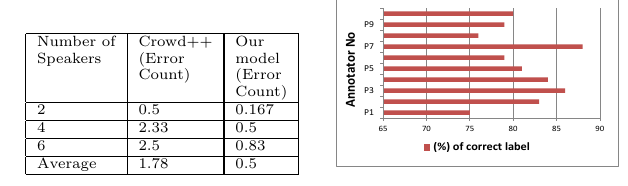
Table 1: Comparison (Av- erage Error Count) between Crowd++ and Our model